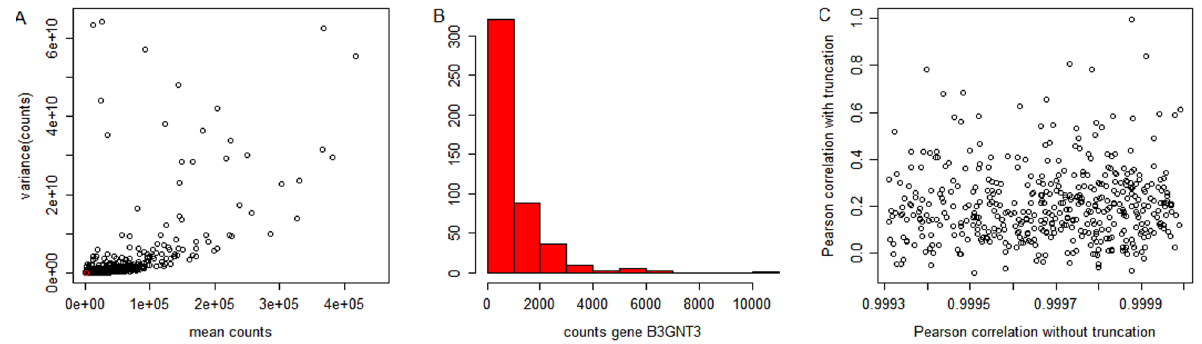
Figure 1. RNA-Seq of KIRC data. A: Scatterplot for all DESeq-normalized counts: Mean vs. variance. The larger the mean value, the larger the variance. The red dot is a randomly chosen gene called B3GNT3. B: Histogram of DESeq-normalized counts for gene B3GNT3. The distribution is skewed and has extreme values. C: 1000 highest gene-gene correlations for the original data compared to the same gene-gene correlations for data in which we truncated the extreme values.